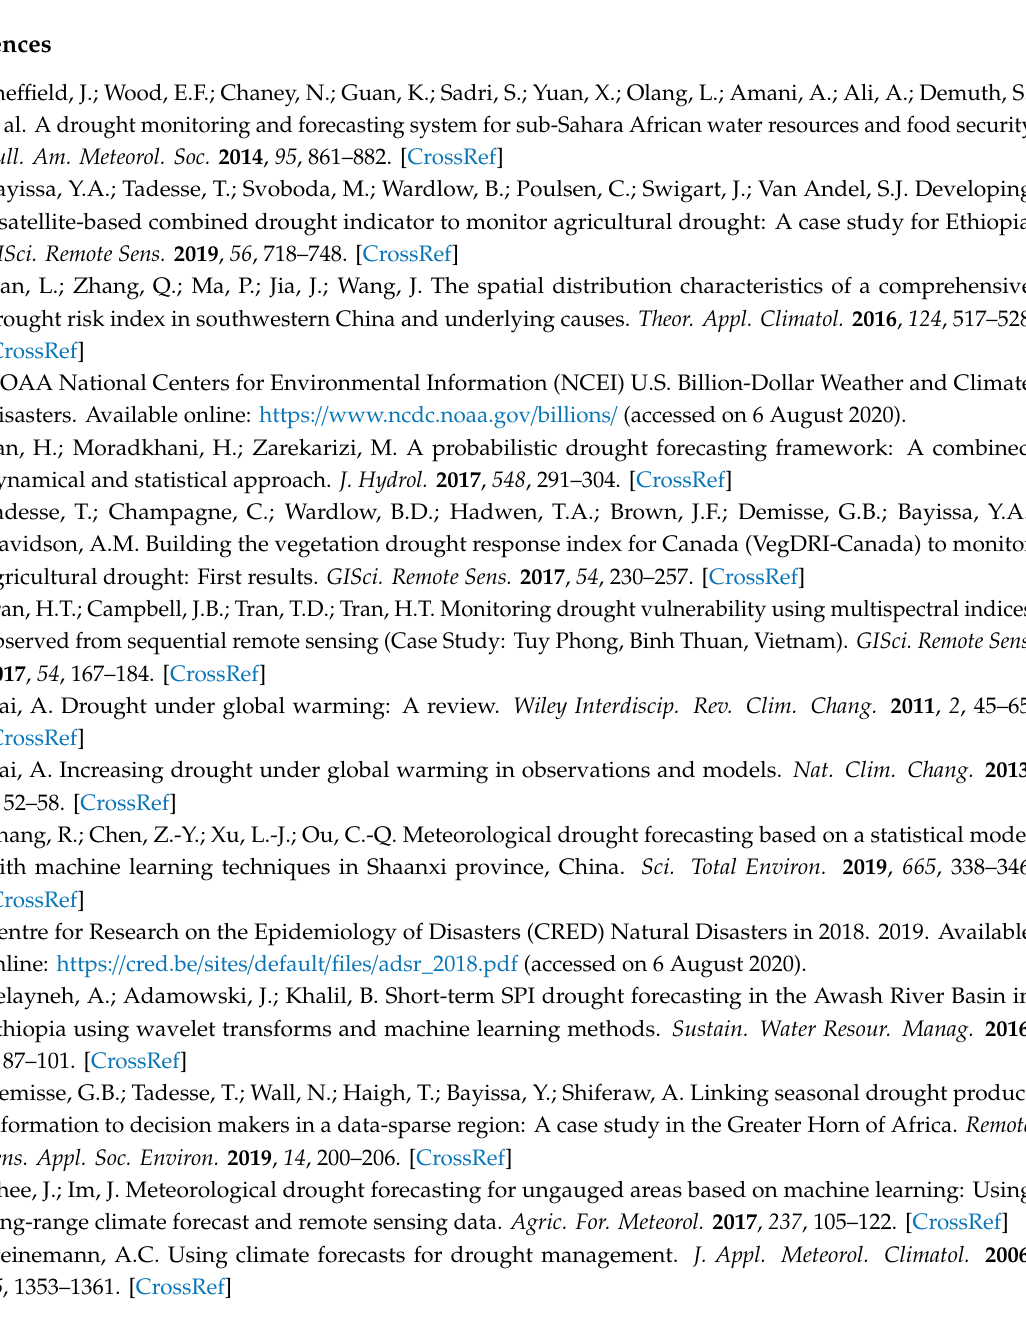
Figure S1. Spatial distributions of r between both drought indices (SDCI and SPI) over 2018; Figure S2. Spatial distributions of r and nRMSE between satellite products and linear-fitted numerical model outputs;Figure S3 Drought conditions for SDCI on DOY 2018129 in Shandong